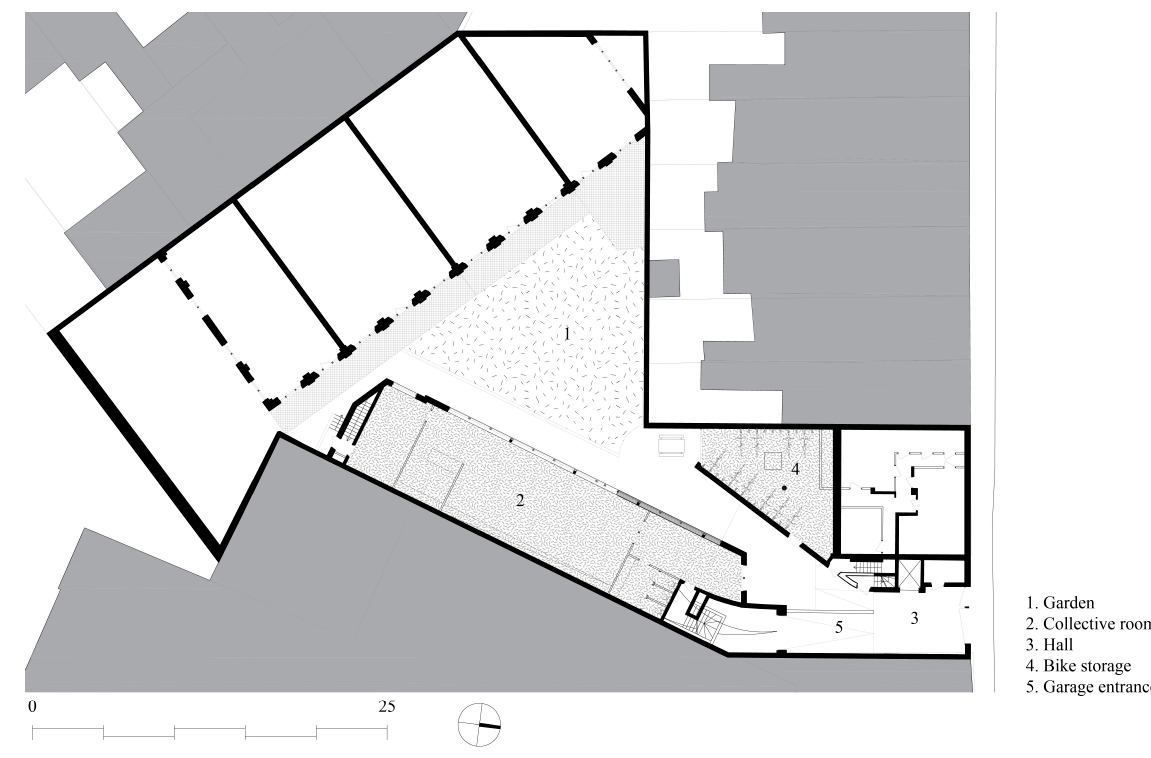
Figure 4. Casa Nova, ground floor—shared spaces (drawn by the authors,